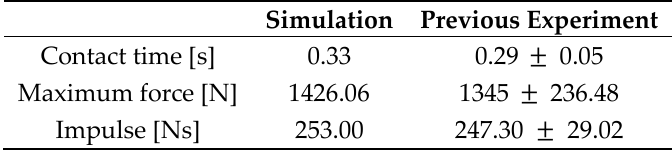
Table 1. Comparison of simulation results with previous research